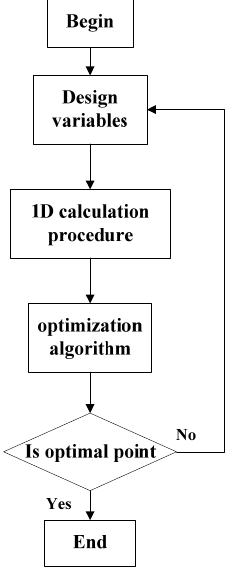
Figure 5. Optimization procedure.